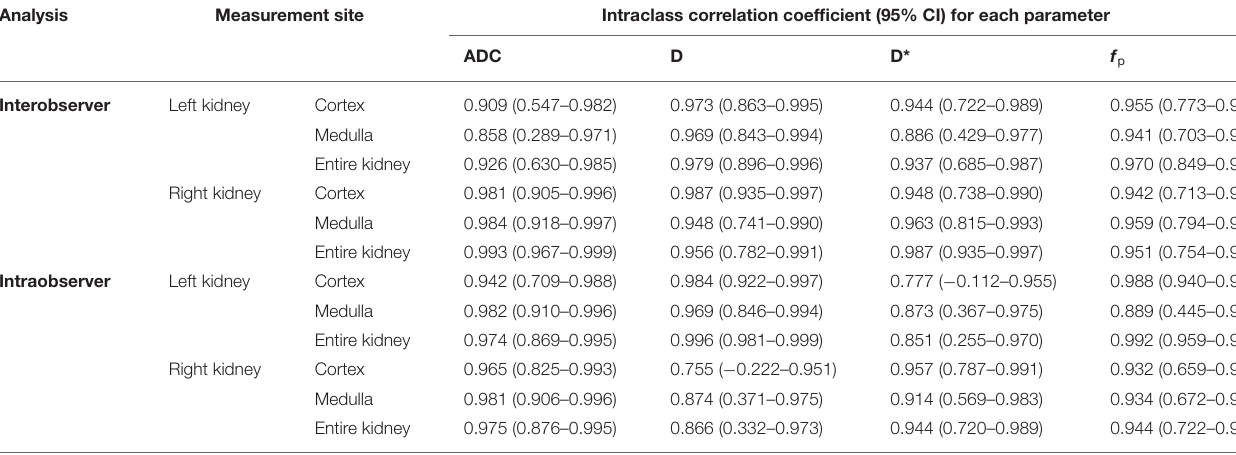
TABLE 5 | Intraclass correlation coefficient values for intraobserver and interobserver reliability of the ADC, D, D * , and f p . Analysis